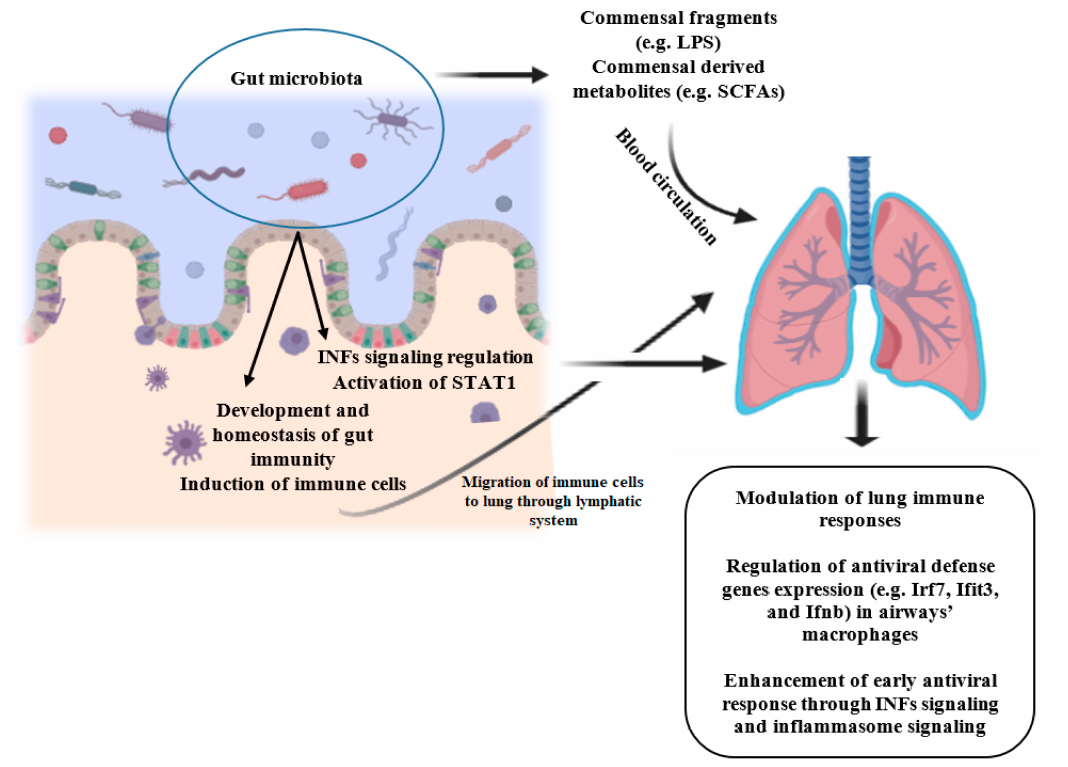
Figure 1. Role of gut microbiota in the prevention of viral respiratory infections. Commensals-derived fragments and metabolites travel to the lung via systemic circulation and can act as signaling molecules and induce immune responses. Furthermore, activated immune cells travel to the lung via the lymphatic system. Besides, gut bacteria regulate the activation of STAT1 and IFNs signaling, which are involved in antiviral defense genes induction prior to infection and immune-mediated resistance to viral infection. INFs: interferons; STAT1: signal transducer and activator of transcription-1; LPS: Lipopolysaccharide; SCFAs: Short-chain fatty acids. Created with